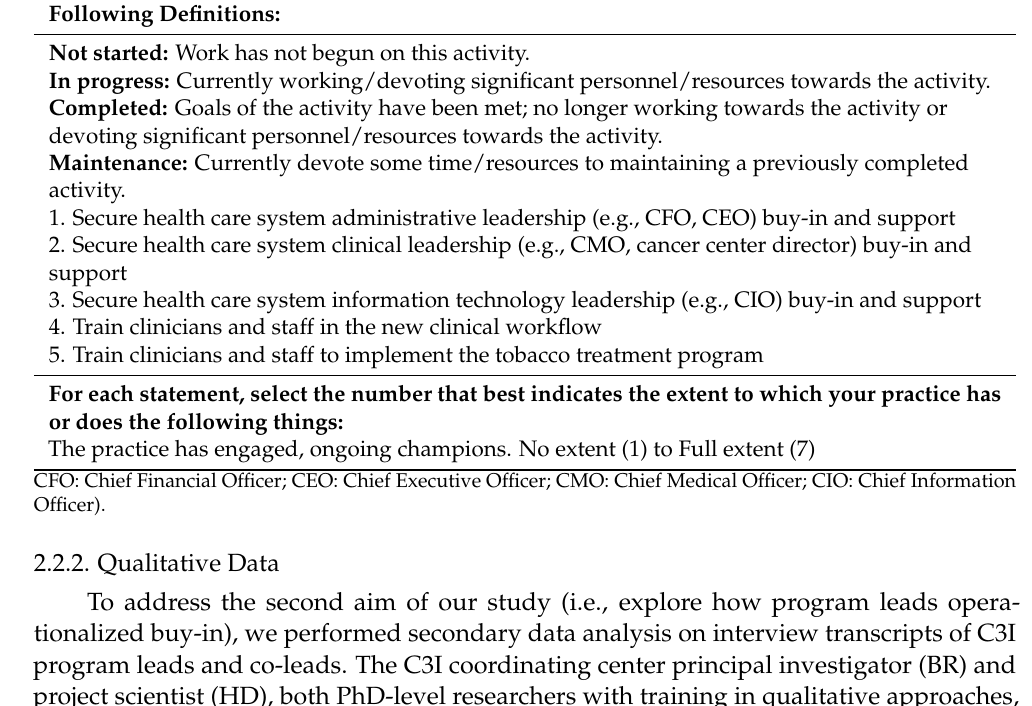
Table 1. C3I survey items to assess leadership and clinician/staff buy-in and presence of clinical